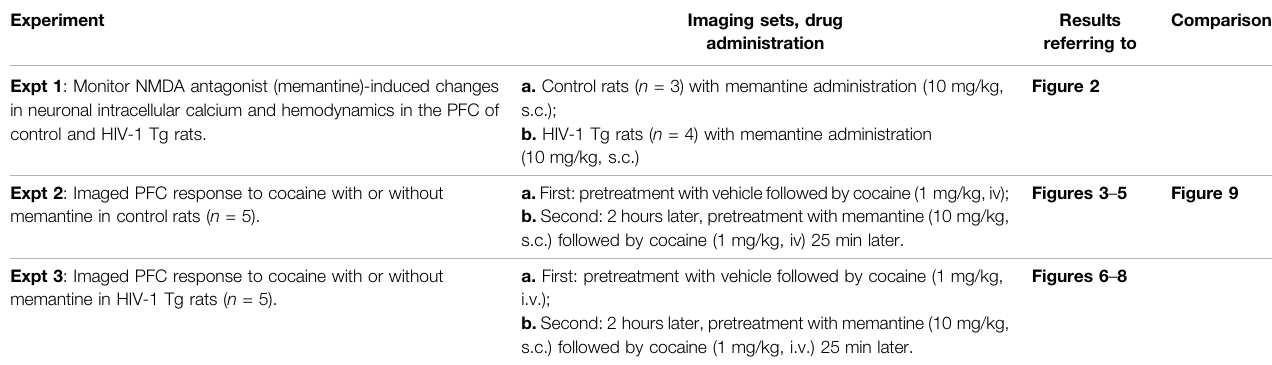
TABLE 1 | Animal groups, experimental design, and outcome referring to/comparison. Experiment Imaging sets, drug